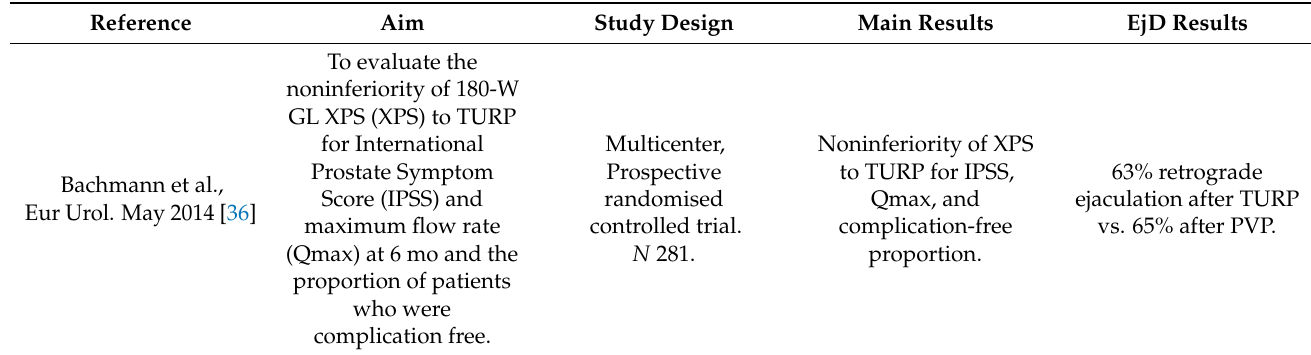
Table 5. Impact of photovaporization of prostate on ejaculatory